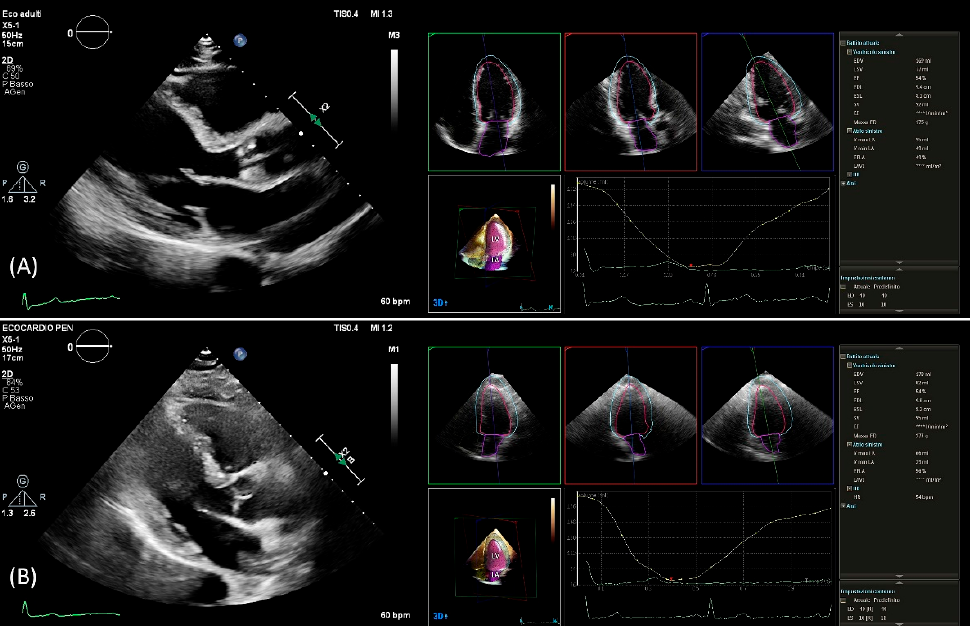
Figure 1. PLAX view used for linear 2D measurements and 3D measurements obtained from automated DHM software in a patient with good agreement ( A ) and in a patient with poor agreement ( B ) between 2D and 3D mass values. DHM, Dynamic Heart Model; PLAX, parasternal long axis; 2D, two-dimension; 3D, three-dimension.